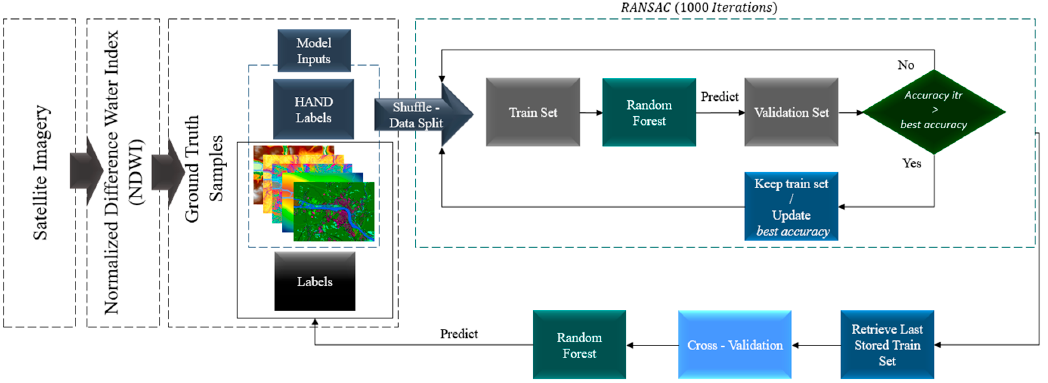
Figure 7. Pseudo Supervised Random Forest (PS-RF) workflow.